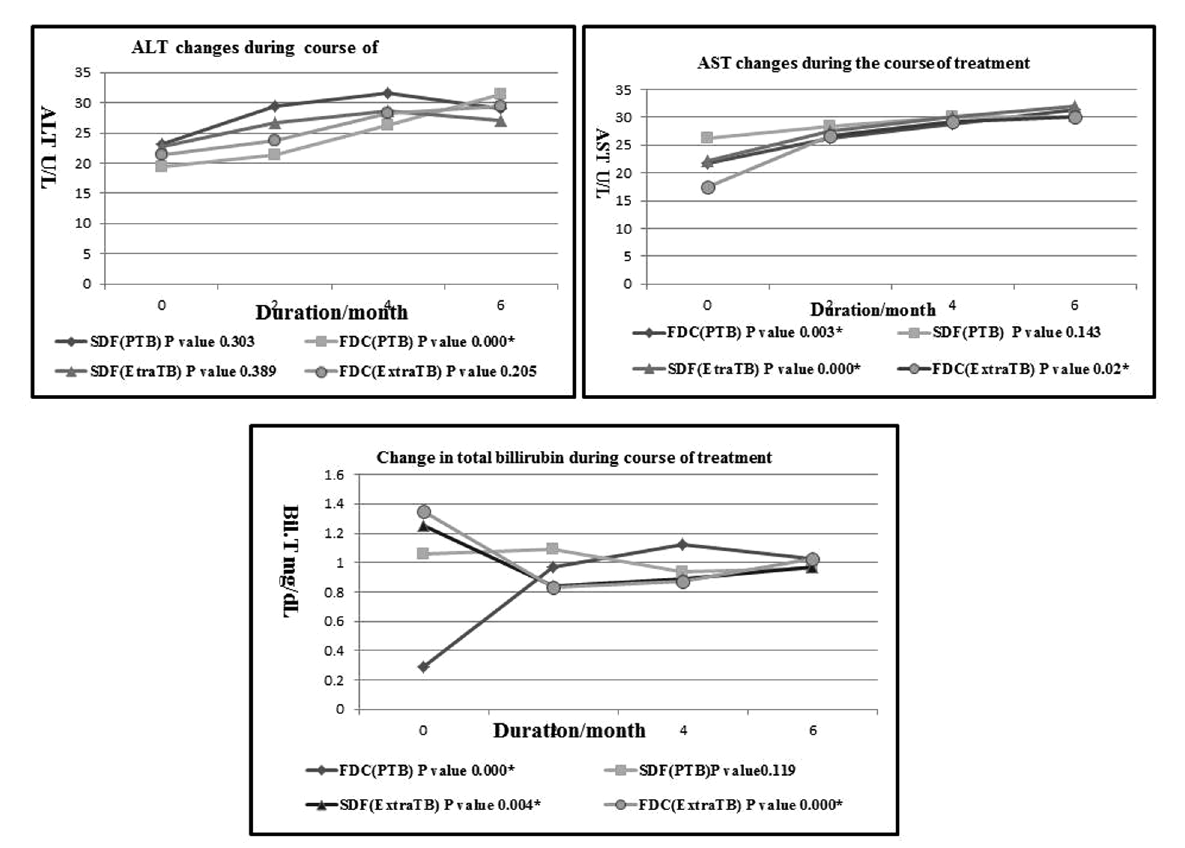
Differences between fixed dose combination and separate formula in treatment of tuberculosis El-Kholy et al.